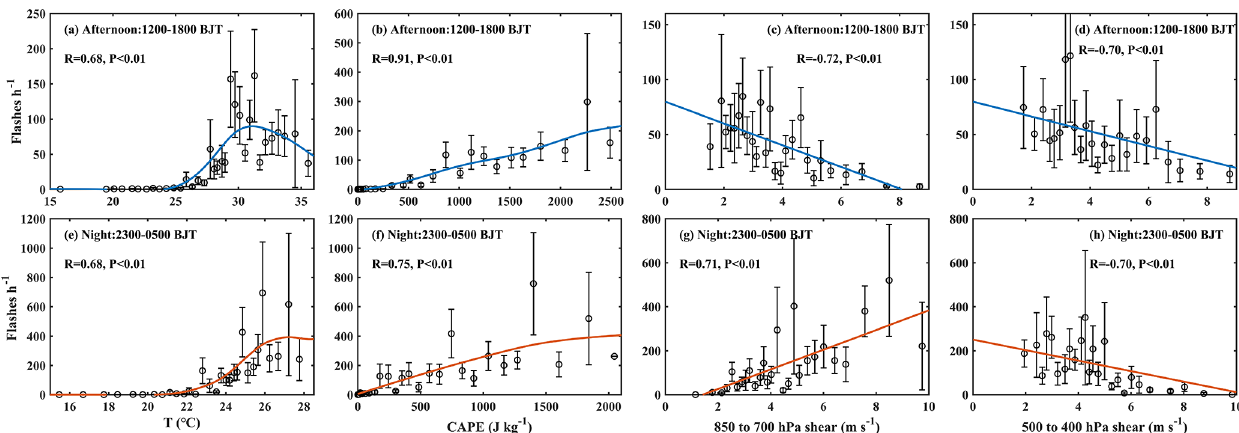
Figure 8. Relationships between lightning flashes and dynamics-thermodynamics factors: (a, e) 2m temperature ( T , unit: ◦ ), (b, f) convective available potential energy (CAPE, unit: Jkg − 1 ), (c, g) low troposphere (850 to 700hPa) vertical wind shear (850 to 700hPa shear, unit: ms − 1 ), and middle troposphere (500 to 400hPa) vertical wind shear (500 to 400hPa, unit: ms − 1 ) in the afternoon (12:00–18:00BJT) and night (23:00–05:00BJT). Note that samples are first sorted by the variable on the x axis and then samples with similar values of the x variable were averaged. The max number of samples in each bin is equal to or less than 20. The difference between the maximum and minimum T , CAPE, 850 to 700hPa shear, and 500 to 400hPa shear values of samples in each bin is equal to or less than 0.5, 200, 2, and 2. An estimation of the uncertainty was calculated from the standard deviation of each bin divided by the square root of the number of data points in the bin. Smoothing spline-fit curves, Pearson correlation coefficients ( R ), and significant level ( P ) are also shown in each panel.